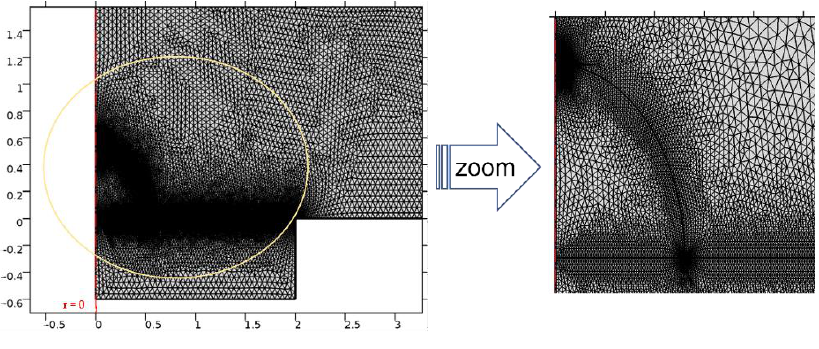
Figure 4. Computational domain and grid.